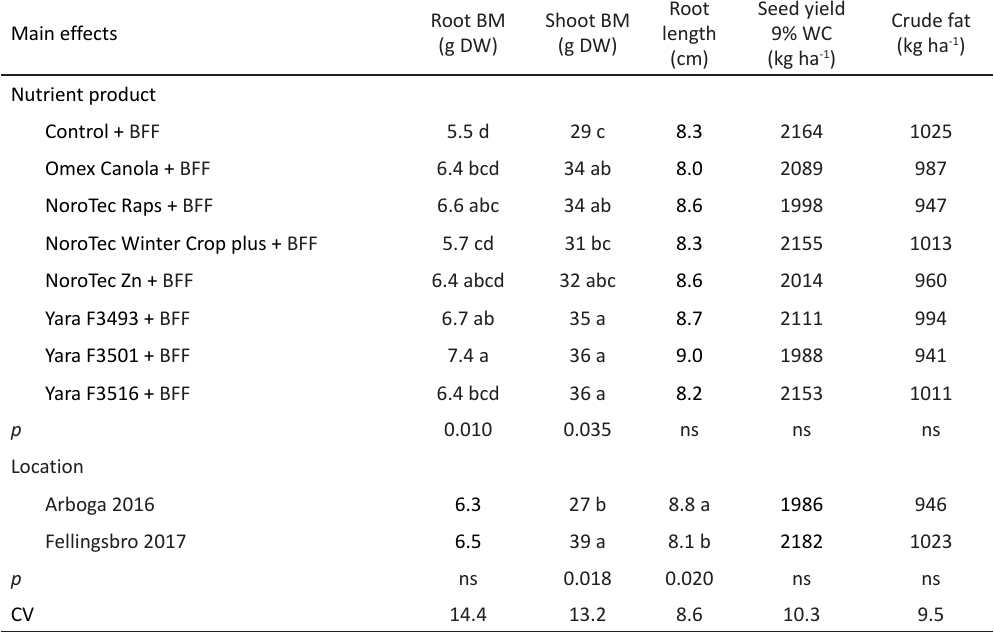
Table 7. Average biomass (BM) at BBCH 60 of roots and shoots, root length, yield of seed and crude fat in spring oilseed rape. The seeds were treated with various mineral nutrient products with (+) the application of binder, filler and Rovral (BFF) in two field experiments; Arboga 2016 and Fellingsbro